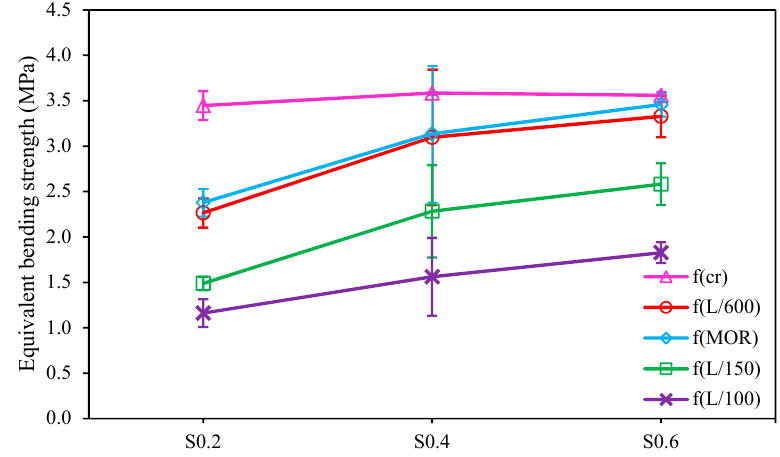
Figure 8. Impact of RTSF dosage on the equivalent bending strength of FR-AASCs.